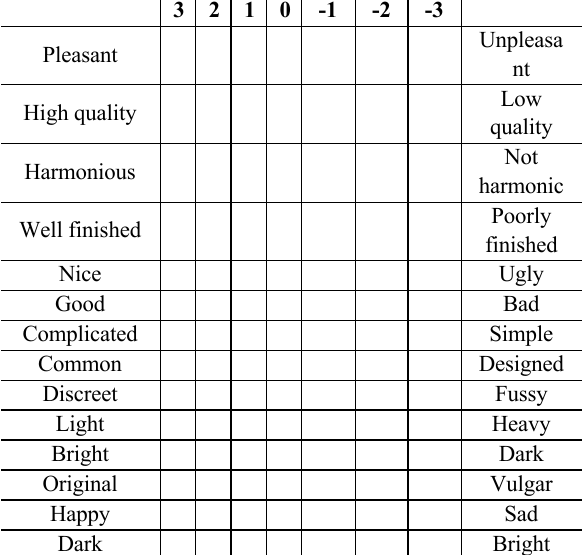
Table 2. Semantics and antonyms used to study wall colours and